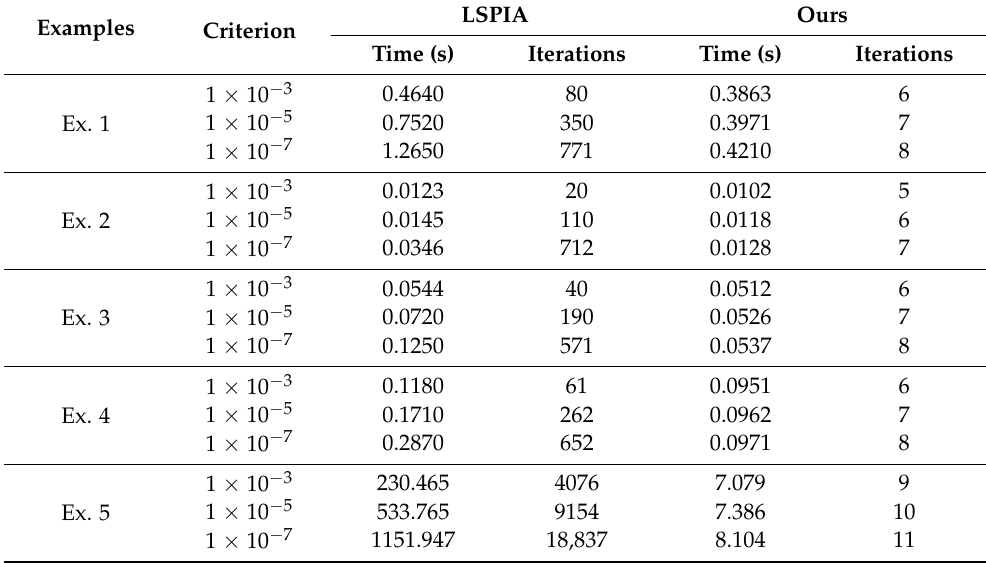
Table 3. Comparison of the iteration number and running time of our method and the LSPIA method under the different termination